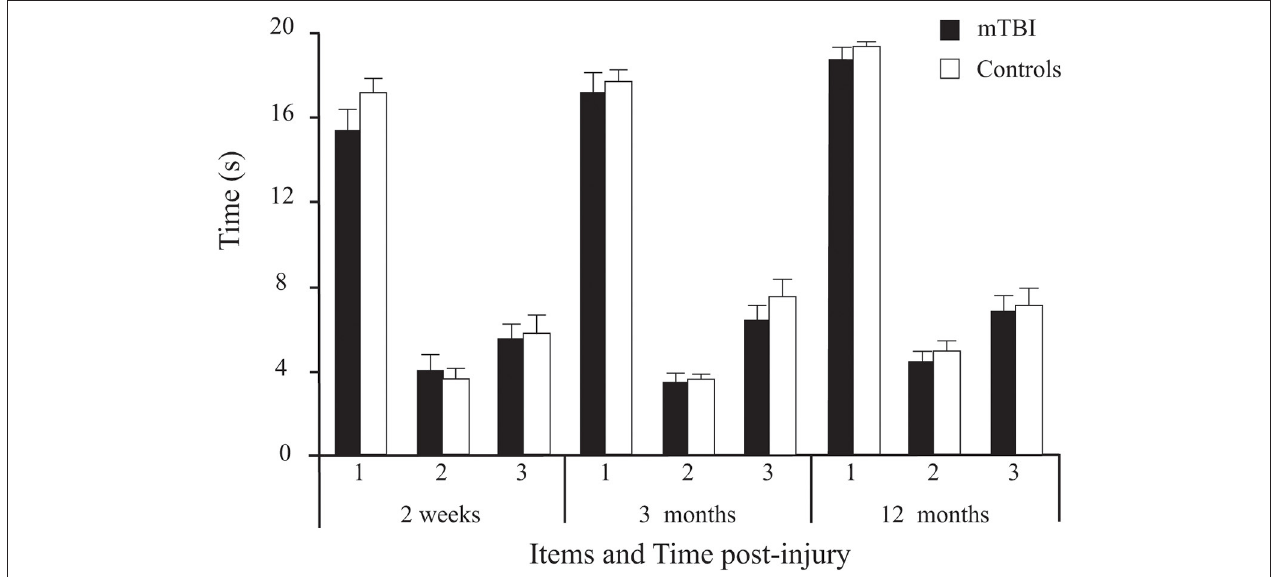
FIGURE 5 | Between-Group differences (Mean ± SEM mTBI vs. Mean ± SEM Controls) on the three timed tasks (average duration of correct stance of the 2 trials/ item, in seconds) as a function of Time post-injury (Session).